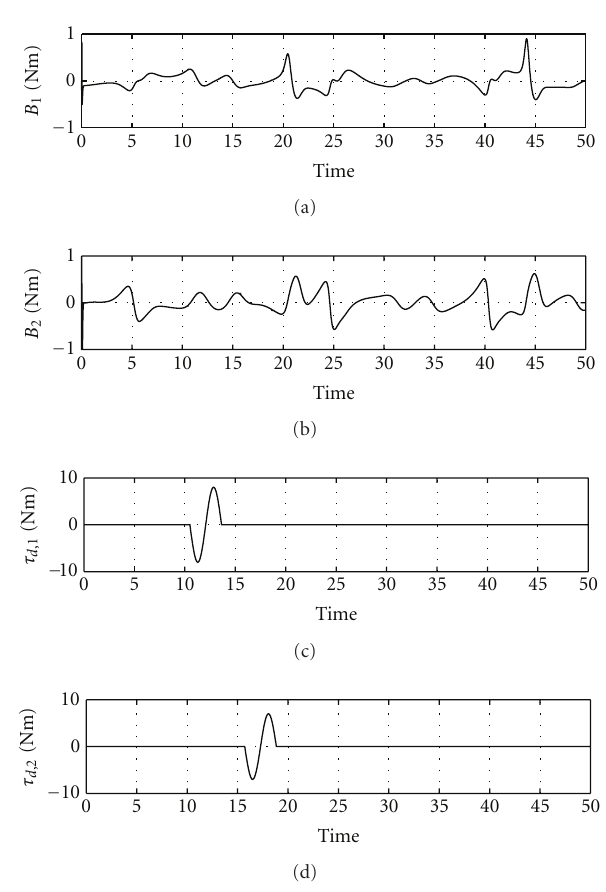
Figure 4: Friction dynamics in each robot joint and external torque perturbations.